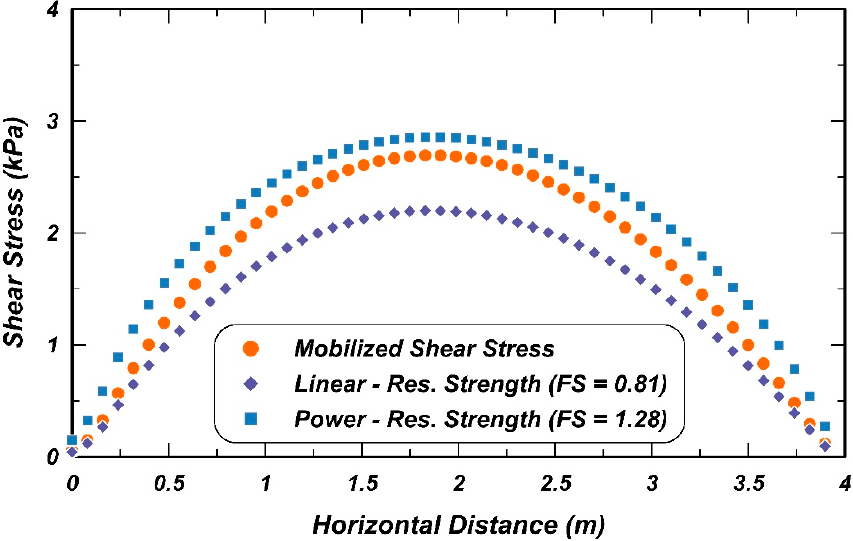
Figure 12. Comparison of mobilized shear stress along the failure surface shown in Figure 10 with the residual strengths from the linear and power fit envelopes.